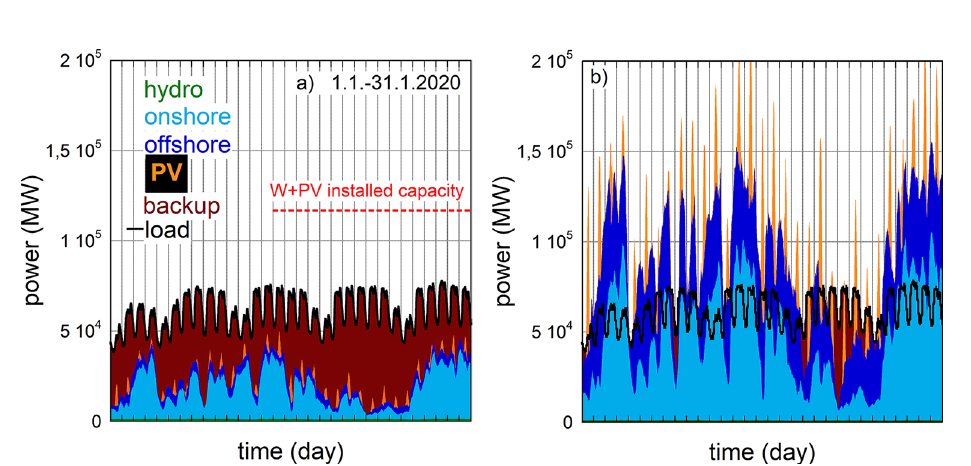
Fig. 3. – Power of renewable energy (RES) and thermal backup systems (a) for January 2020, and (b) up scaled to the production in 2045 according to the installations as suggested by “AGORA Energiewende” [9] with the following specification: onshore = 145 GW, offshore = 70 GW and photovoltaic power = 385 GW. The black curve represents the load of 2020 which has been left unchanged up to 2045 (alternative loads are discussed later in the text). For 2020, the installed intermittent renewable (iRE) power of 116 GW is indicated as dashed red line in fig. 3(a); for 2045, it is expected to be 600 GW